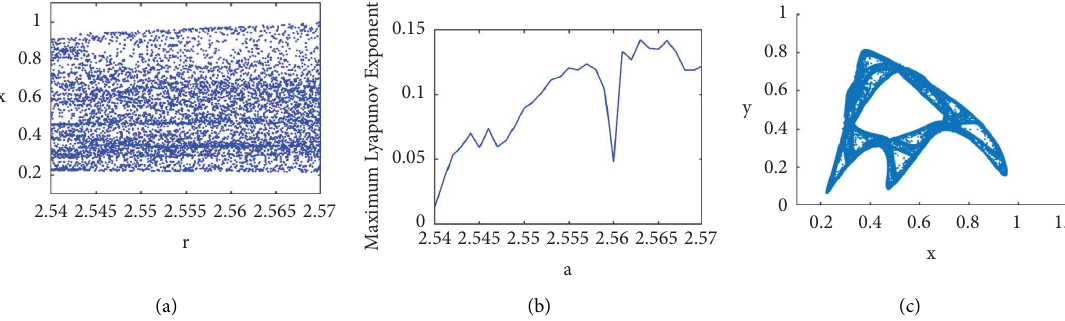
Figure 6: (a) Bifurcation diagram of the model (4) in ( r,x ) plane. (b) Maximum Lyapunov exponents corresponding to (a). (c) Chaotic attractor for r � 2 . 55 in (a).